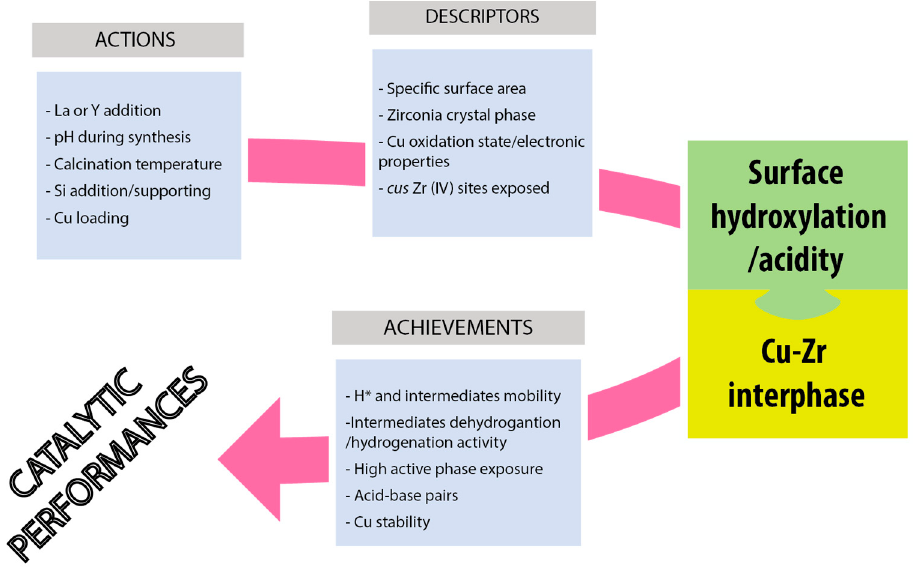
Figure 1. General guidelines for the preparation of an active copper–zirconia catalyst.